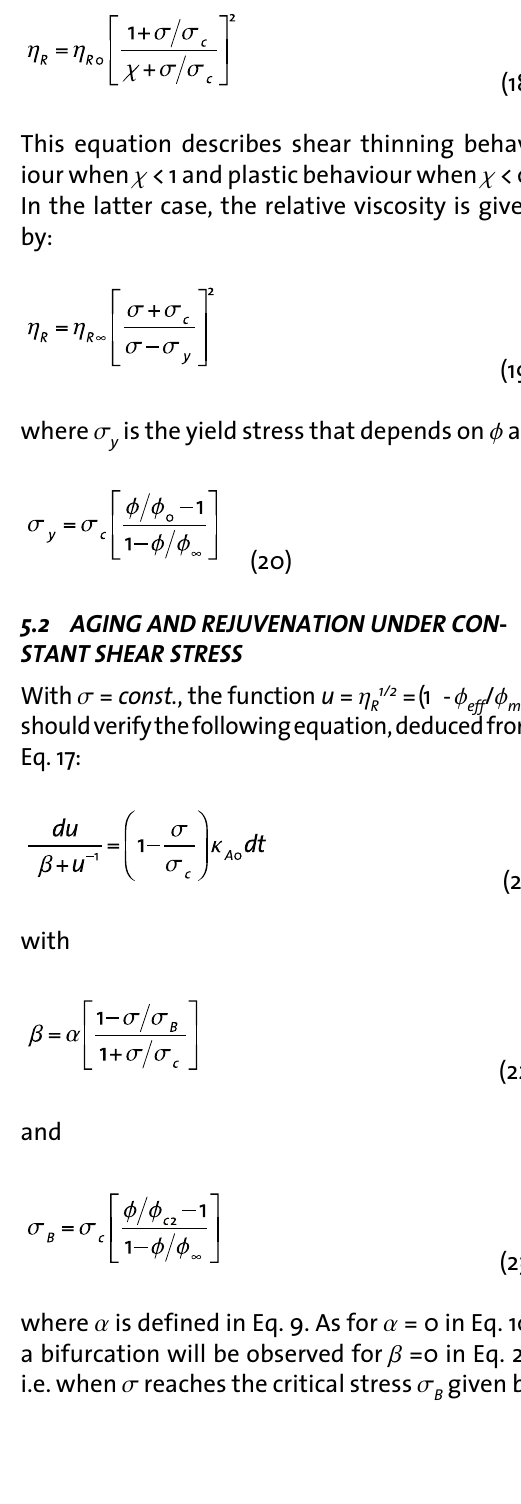
Figure 4: Relative viscosity versus reduced time t = k t under R A0 (s -1 ) = g · = const. Values of k D k g · = 0, 10 -7 , 10 -5 , 10 -3 , 10 -1 , 1, c 10, 10 2 , 10 3 , 10 4 (growing from top to bottom). The critical value which gives h = const. is k = 1.96 ( f = 0.50, DK k = 0.5, S = 0.4 (same val- c init ues for other parameters as for Figure